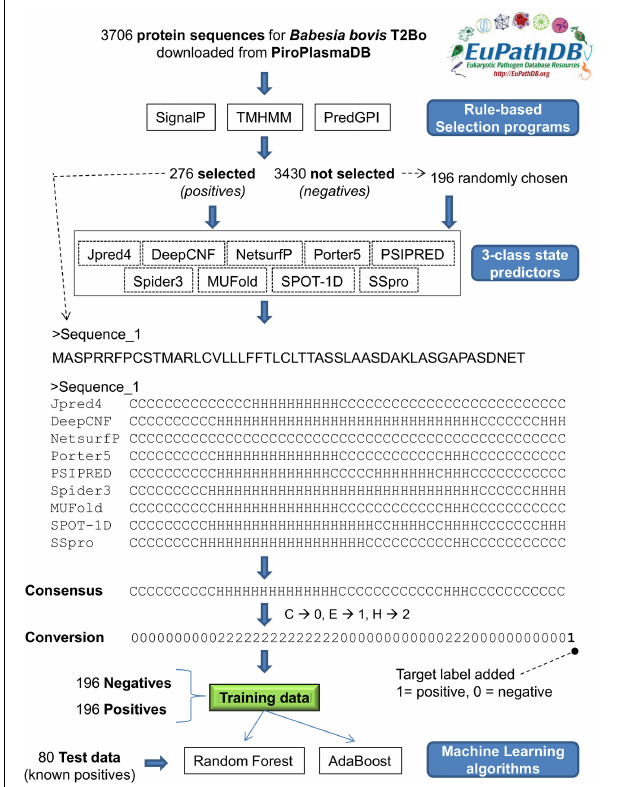
FIGURE 2 | Schematic of steps taken to determine the exportome membership of Babesia bovis T2Bo proteins using machine learning and three-class state predictions for protein secondary structure. (1) Following a rule-based selection procedure, protein sequences from 276 proteins fulfilling the selection criteria (positives) + 196 failing the selection criteria (negatives) are input to nine 3-class conformational state predictors, (2) a consensus